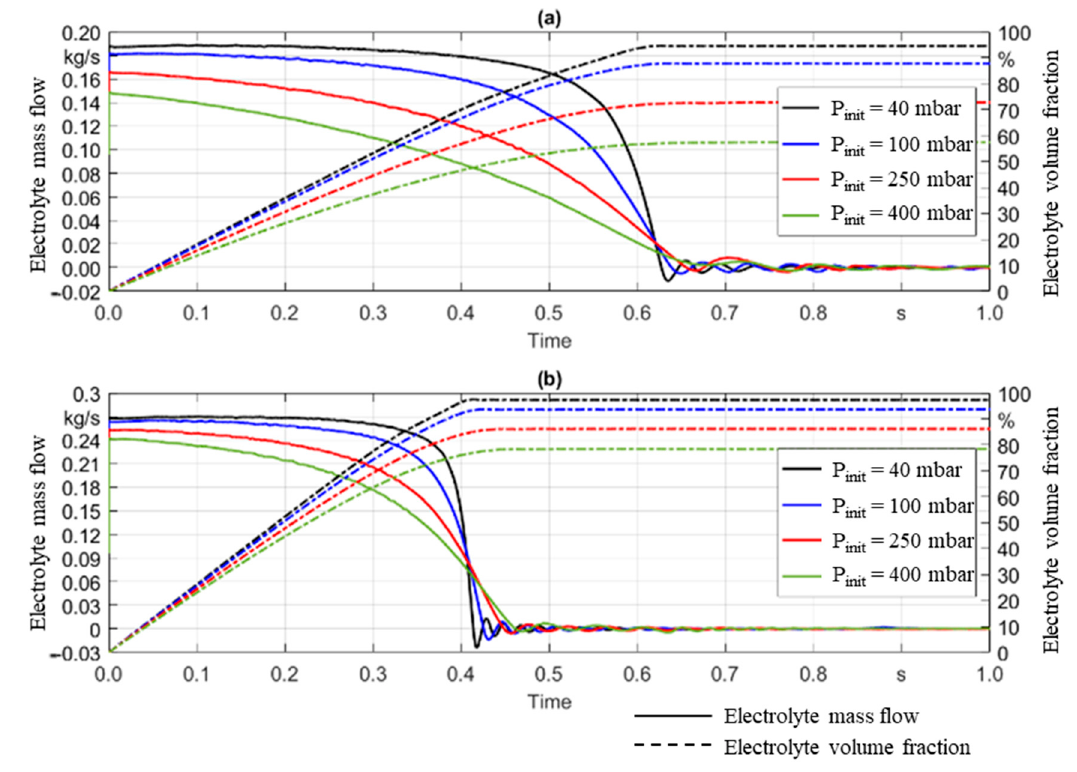
Figure 4. Influence of pressure variation on the mass flow and volume fraction of electrolyte as a function of time is shown. ( a ) Gauge pressure of 1000 mbar and temperature of 25 °C were applied with varied initial evacuation pressure from 40 mbar to 400 mbar. ( b ) Gauge pressure is increased to 2000 mbar with the same temperature and initial evacuation pressures.